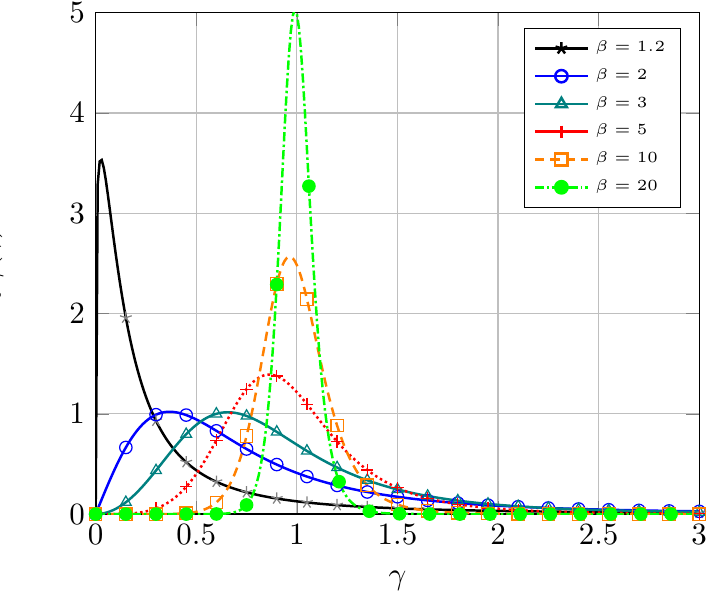
Figure 1. Probability density function of the received SNR under L -distributed fading for different values of β . Parameter γ = 1 and then α = sinc ( 1/ β )